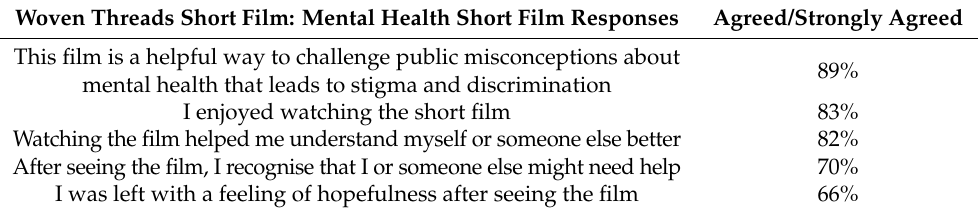
Table 3. Viewer responses to Woven Threads Mental Health short film ( n = 275).